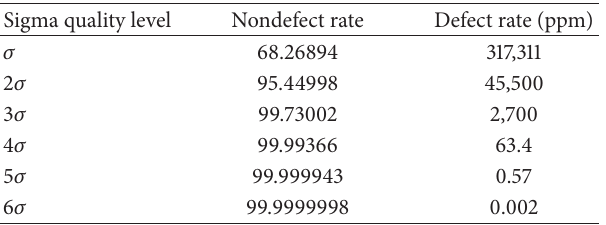
Table 1: Probability of defects of different Sigma levels at a fixed process mean reproduced from elsewhere